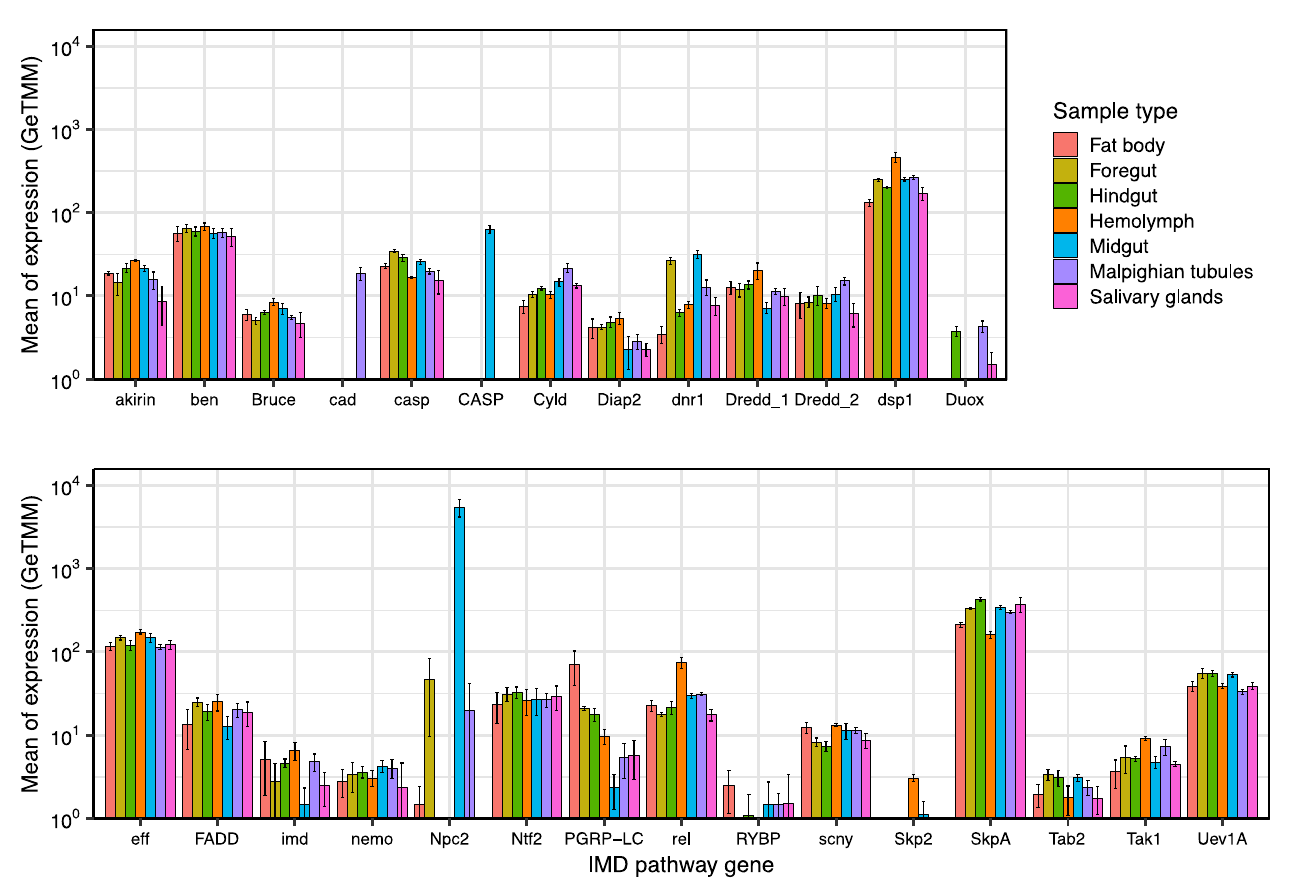
Figure 1. Expression of genes of the IMD pathway in adult females of B. germanica . Values are the means plus standard deviations of normalized expression (GeTMM) of each gene in each sample type. Graph bars are standard deviations. See Table 1 for product names. Y-axis is in log scale. The lower ends of the error bars are not shown below 10 0 . Genes are arranged in alphabetical order from left to right and top to bottom.